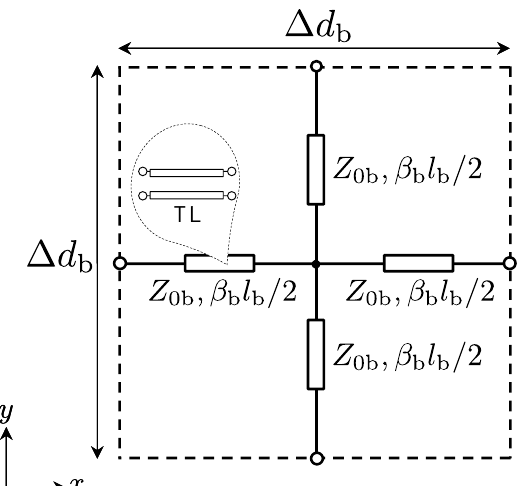
Figure 5. 2-D distributed TL model for the background medium.